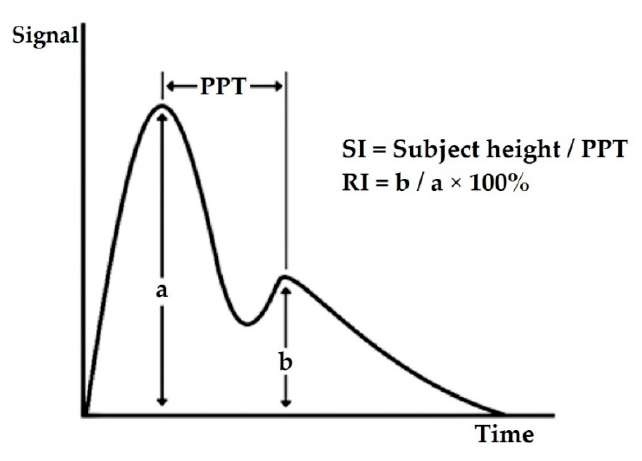
Figure 1. Stiffness index (SI) [27]. Figure 1. Sti ff ness index (SI) [27].